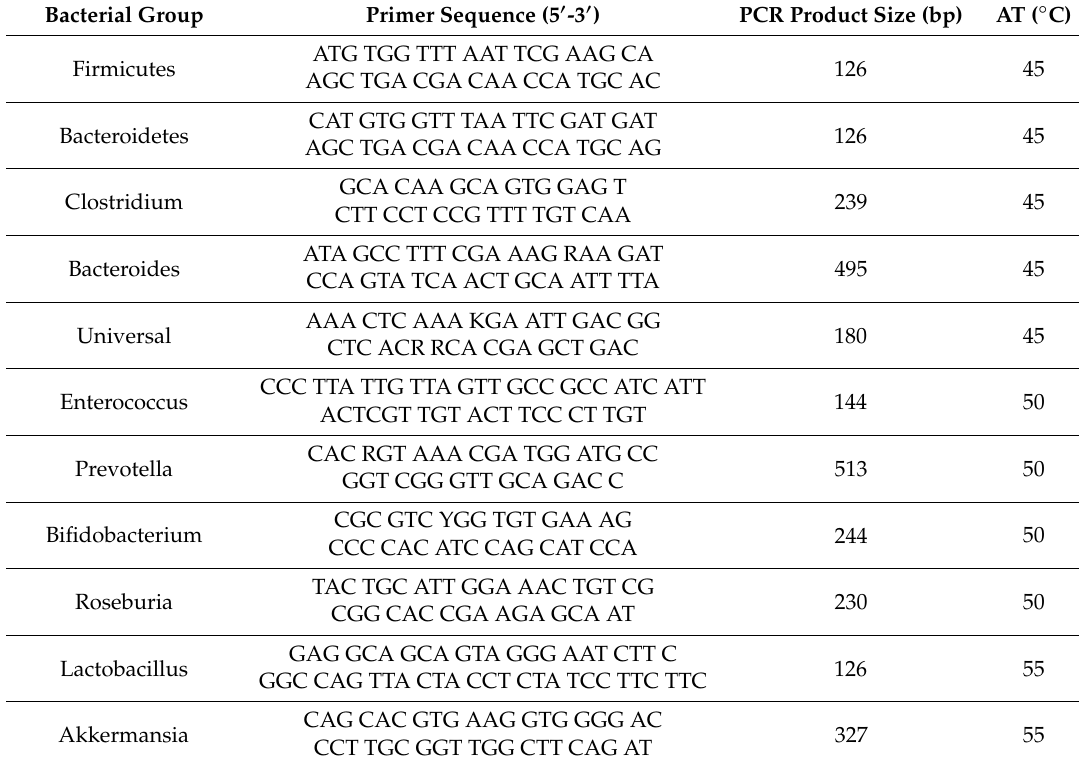
Table 1. Primer sequences and real-time PCR conditions used for gut microbiota analysis. Bacterial Group Primer Sequence (5 (cid:48) -3 (cid:48)